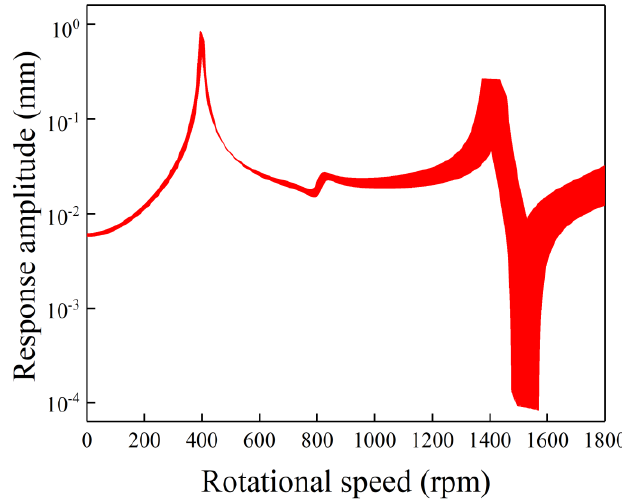
Figure 10. The bounds of uncertain gravity response versus rotational speed by CIM with a 5% deviation in Young’s modulus and a 5% deviation in density.